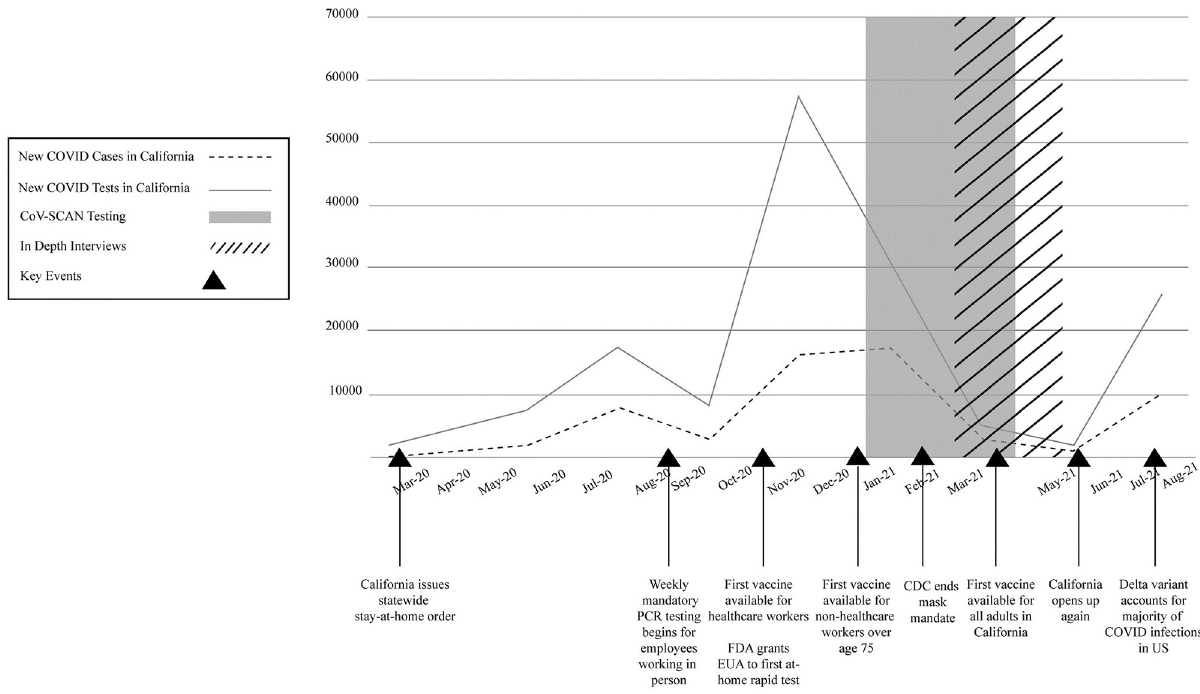
Fig 1. Timeline of key study and COVID-19 pandemic